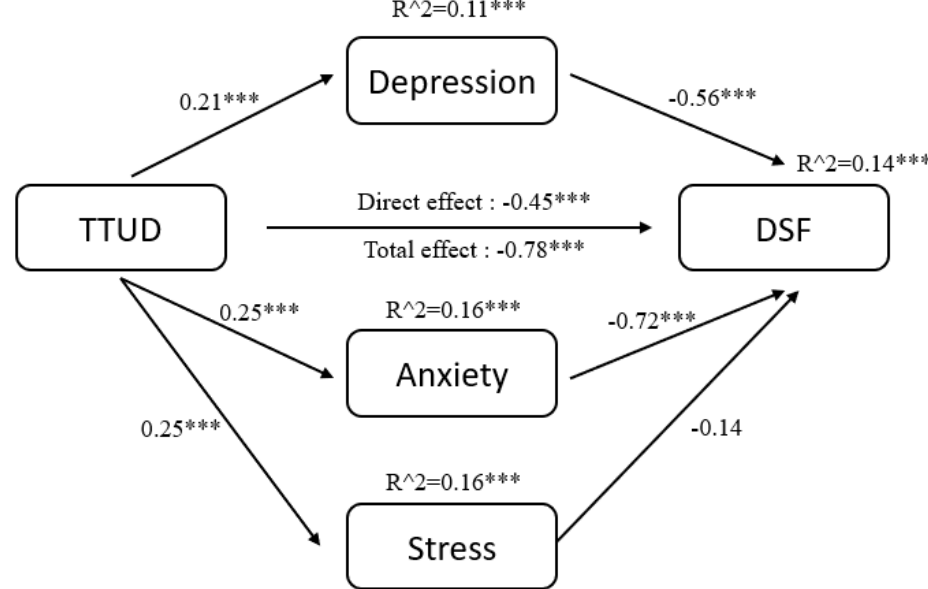
Figure 2. Structural model of forward digit span test for male and female participants. TTUD, TikTok use disorder; DSF, forward digit span. *** p < 0.001.